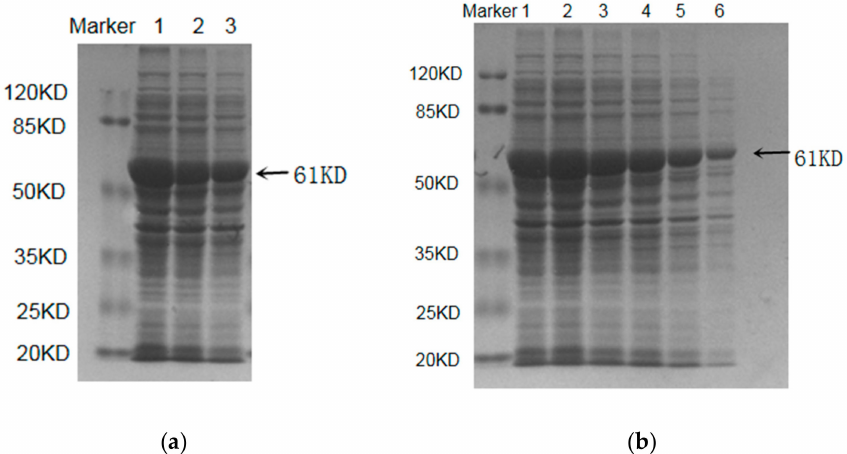
Figure 1. The induced expression of glutathione synthetase. ( a ) the e ff ect of the di ff erent inducers. Lanes 1, 2, and 3 show GSH induced by Tianda No.1, lactose, and IPTG, respectively; ( b ) GSH at di ff erent low temperatures. Lanes 1–6 show the glutathione synthetase expression that was induced at 30 ◦ C, 26 ◦ C, 22 ◦ C, 18 ◦ C, 14 ◦ C, and 10 ◦ C, respectively, by the Tianda No.